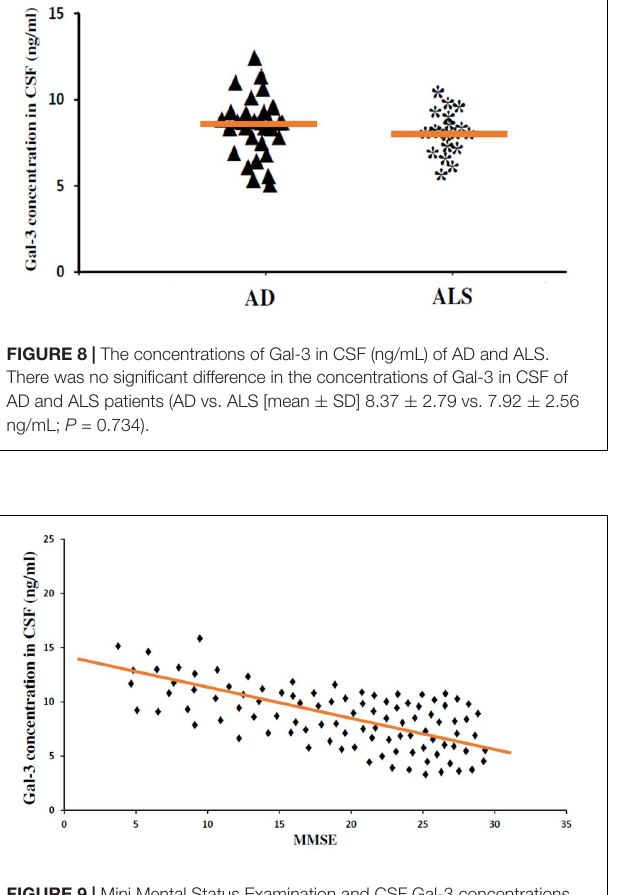
FIGURE 9 | Mini Mental Status Examination and CSF Gal-3 concentrations. A significant correlation was observed between MMSE score as a measure of cognitive status and CSF Gal-3 levels ( P = 0.306; P < 0.001) in all the patients (AD = 31, ALS = 19, Controls =